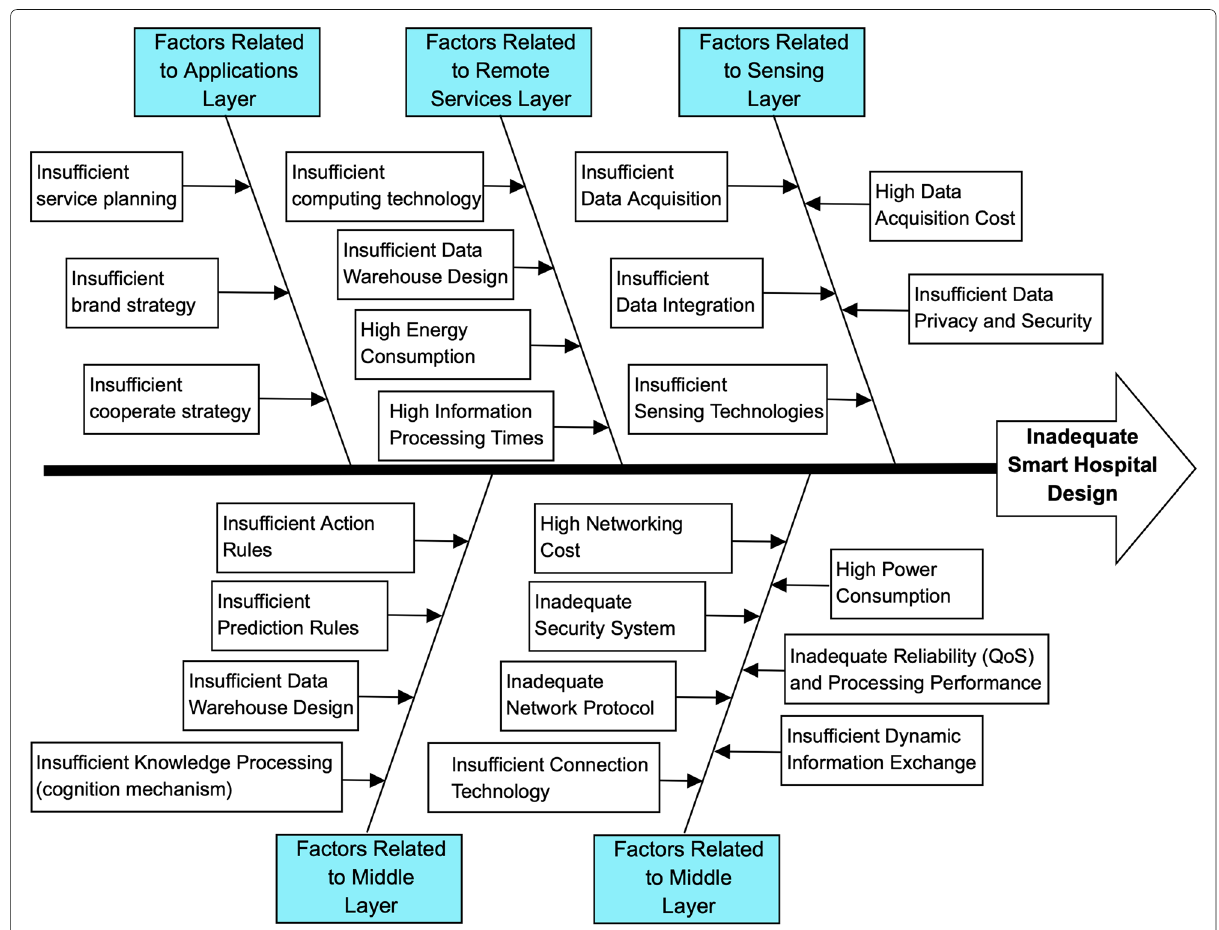
Fig. 4 Cause and effect diagram for inadequate smart hospital